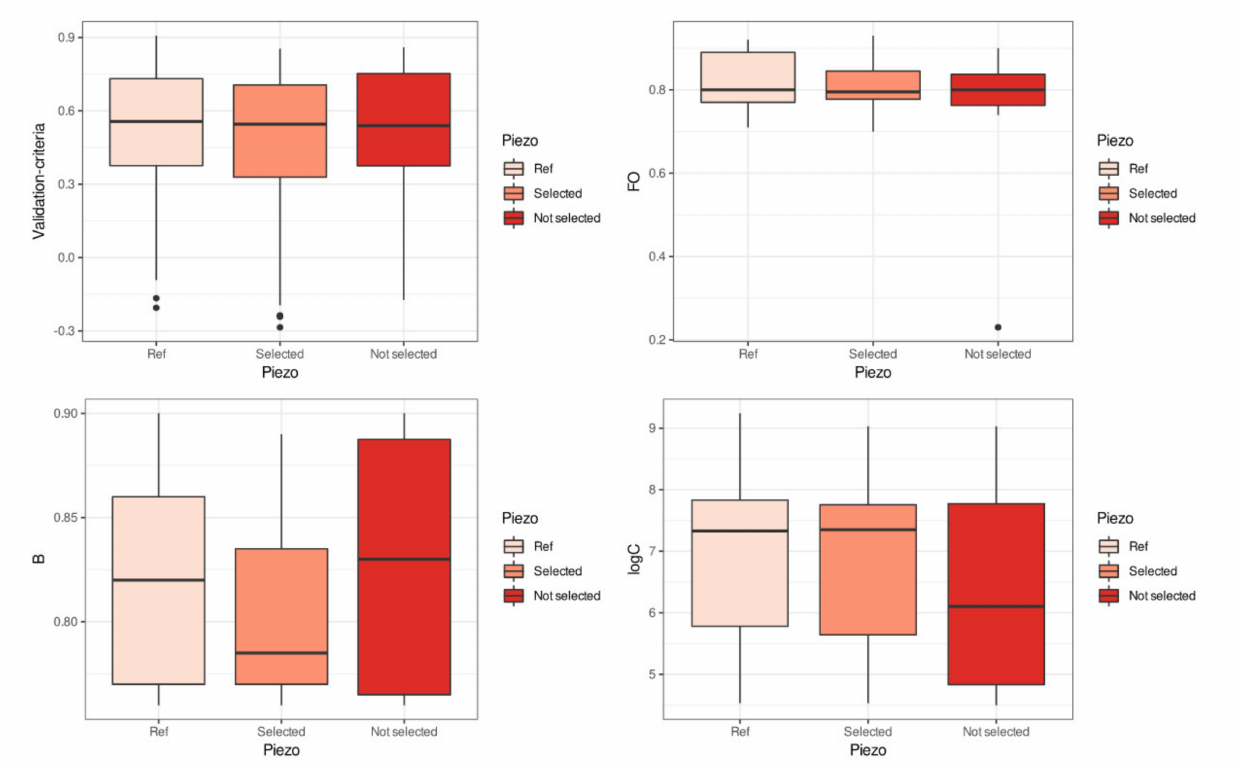
Figure 13. Distribution of the validation criteria comparison, the objective function FO (Q, H) KGE, and parameter B and C values as a function of choosing a piezometer for